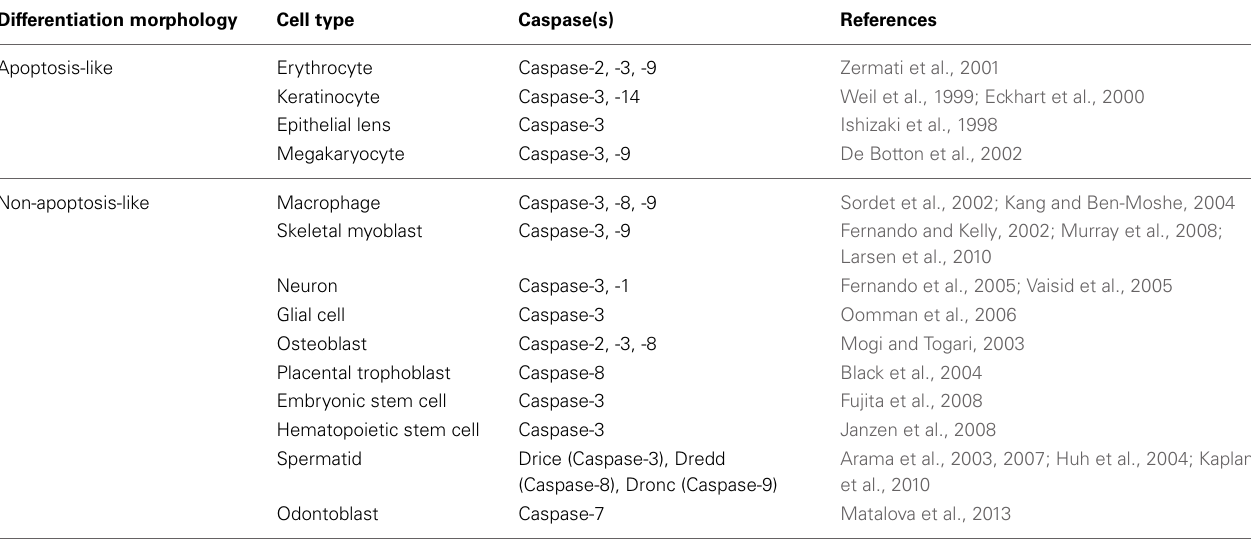
Table 2 | Caspase involvement in the differentiation programs of several cell types. Differentiation morphology